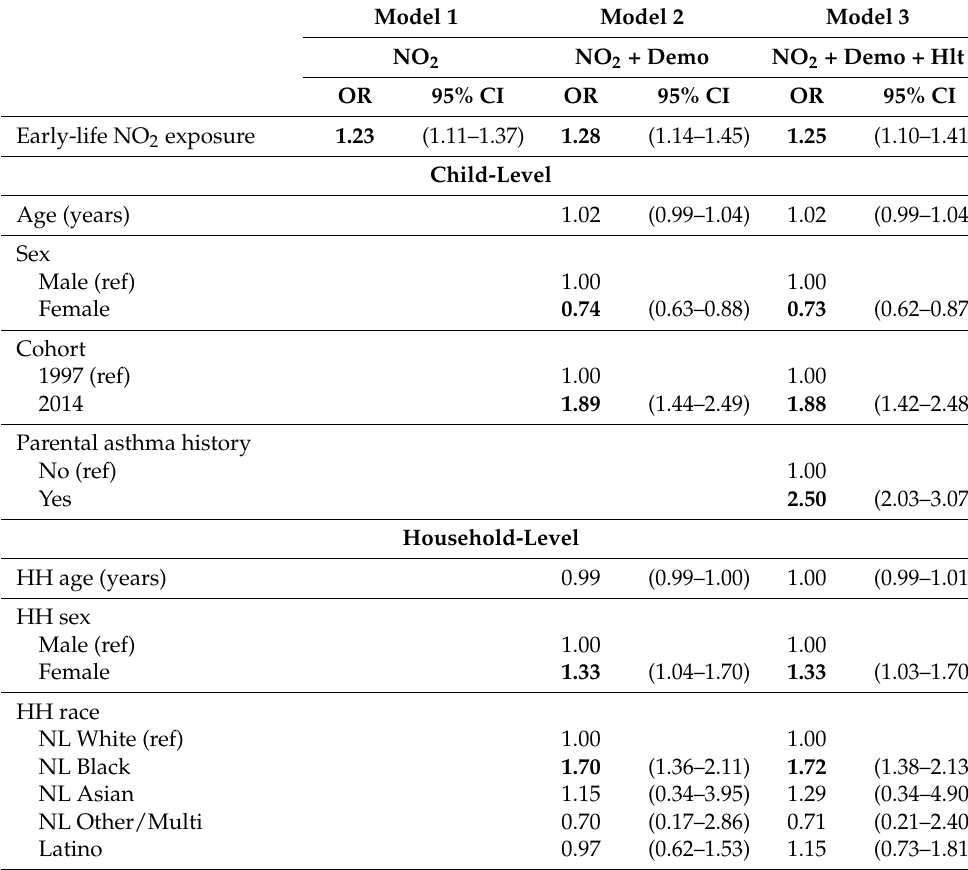
Table 2. Association of early-life NO 2 exposure with childhood asthma risk, PSID–CDS, 1990–2014 ( N =